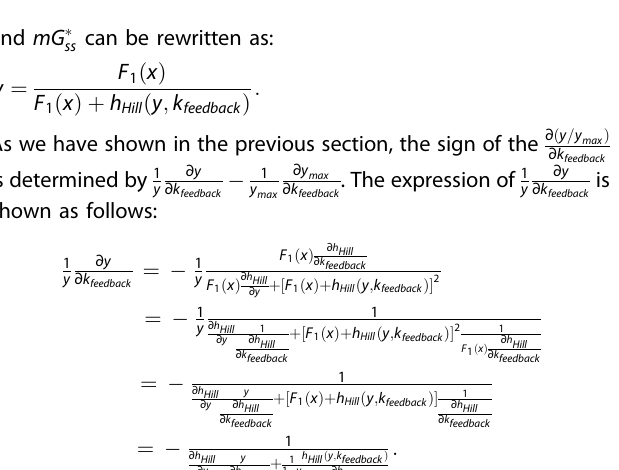
for the OR logic